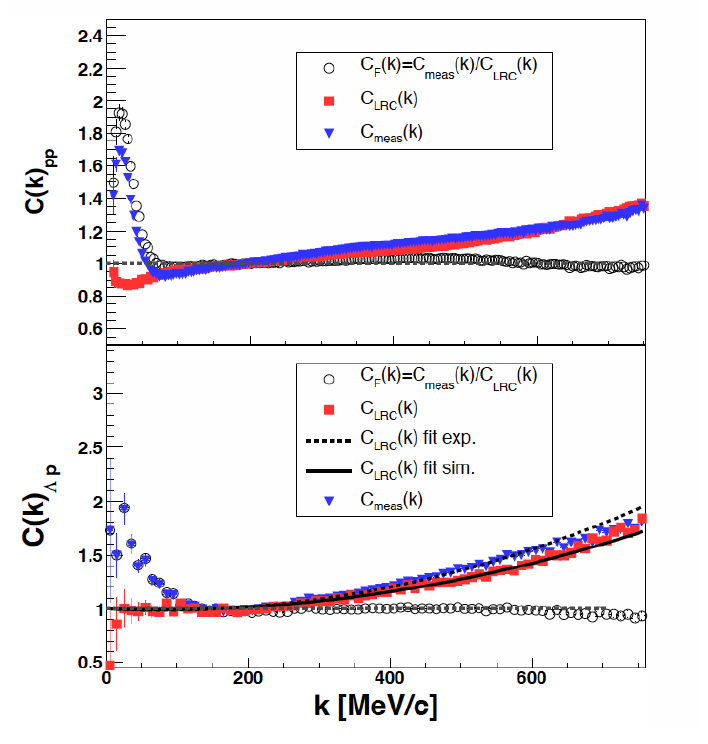
Figure 4. Proton-proton correlation function (top) used to extract source size and proton-lambda (bot- tom) correlation functions, femtoscopic correlations together with long-range correlation [9].